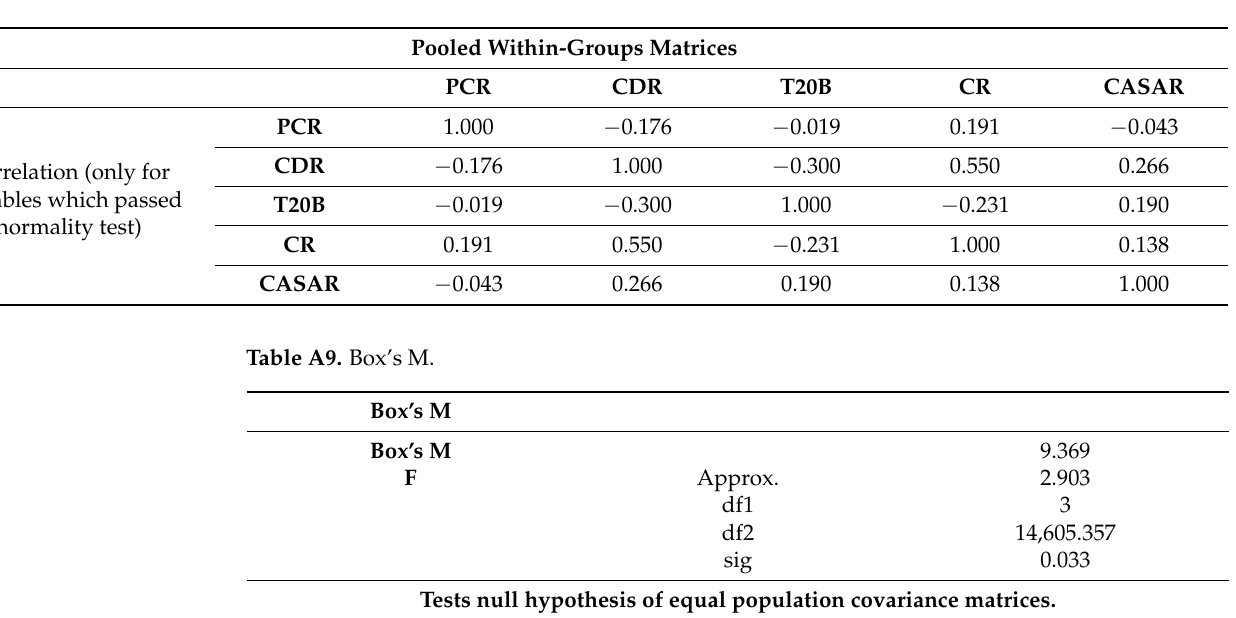
Table A8. Correlation.